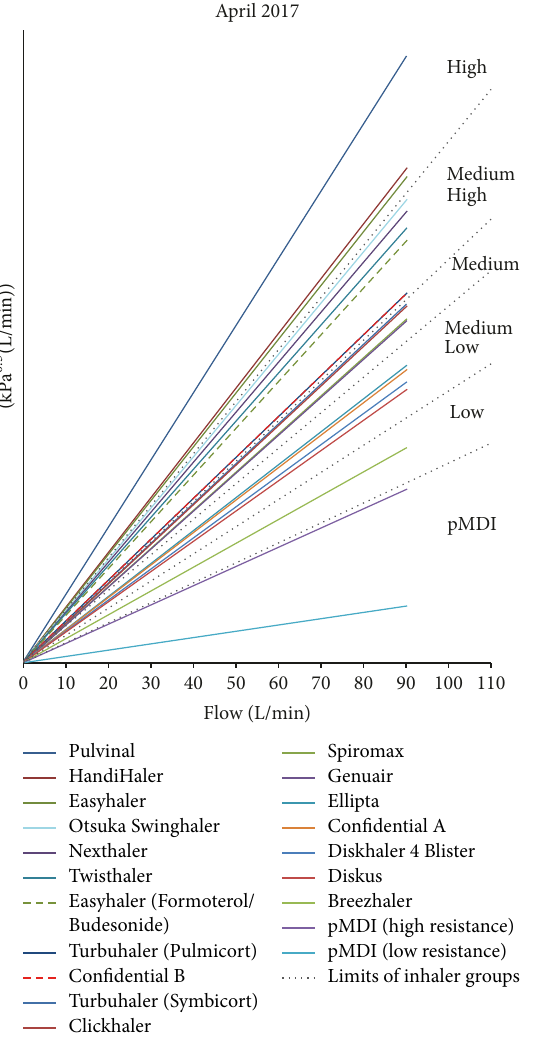
Figure 3: In-Check DIAL G16 ranges of device